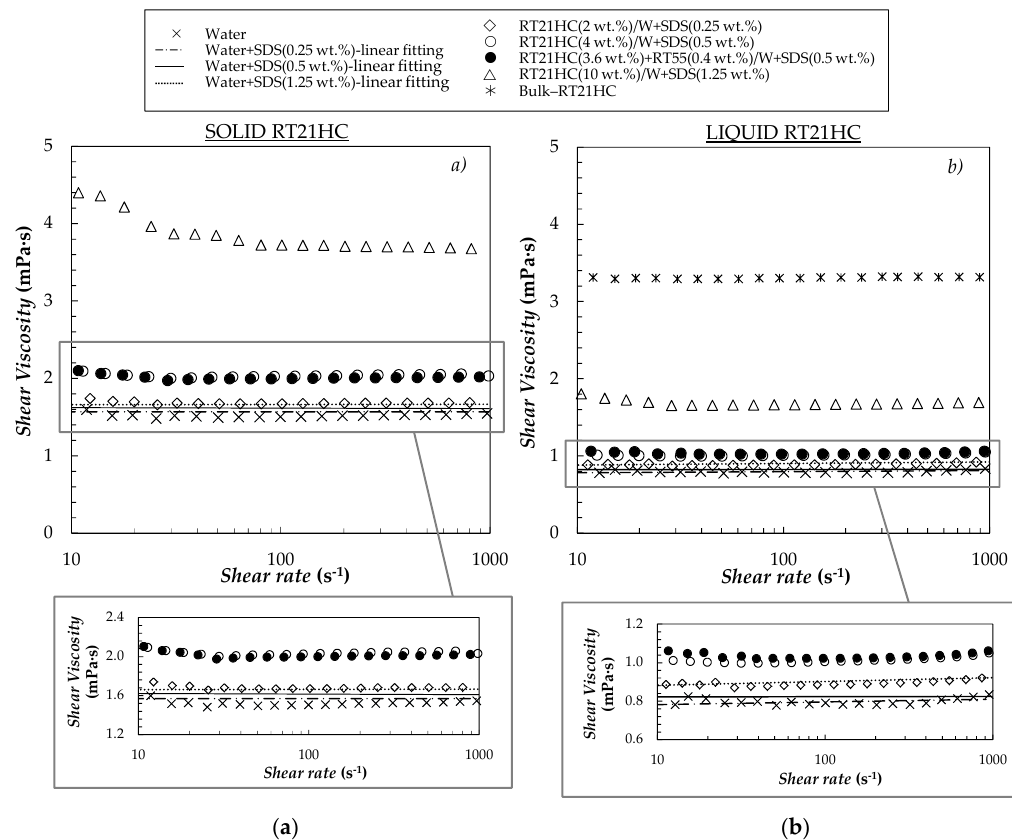
Figure 2. Shear viscosity–shear rate flow curves at ( a ) 278.15 K, when paraffin droplets are solid, and ( b ) 303.15 K, liquid paraffin droplets.